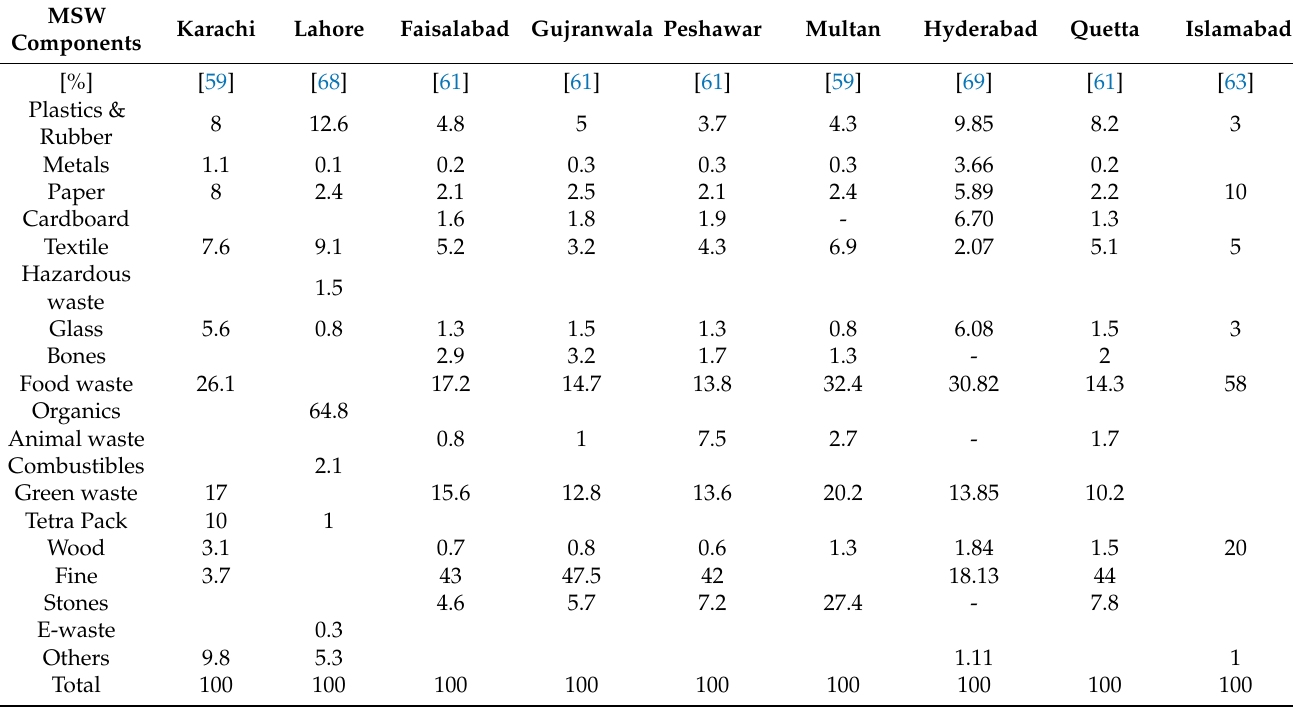
Table 4. Physical composition (% wet weight basis) of MSW major cities in